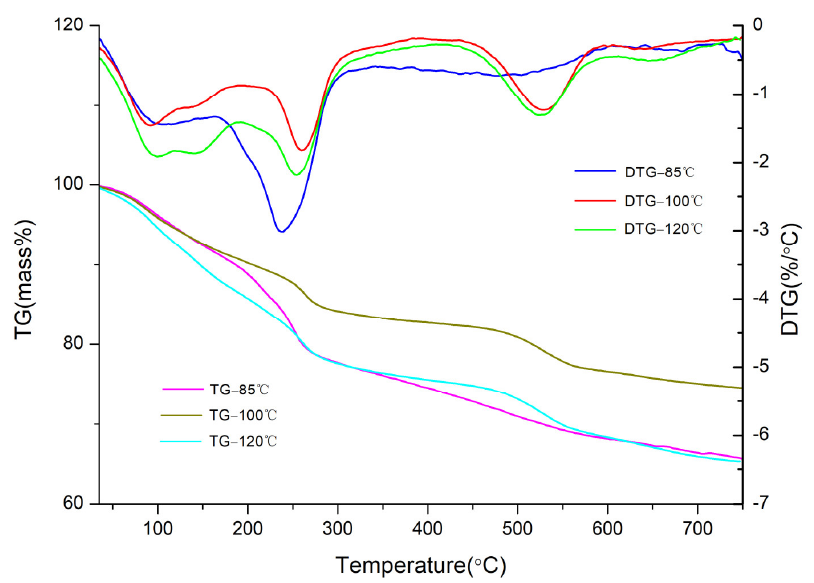
Figure 5. TG-DTG image of CaAl–SiO 3 –LDHs samples prepared at different crystallisation temperatures.